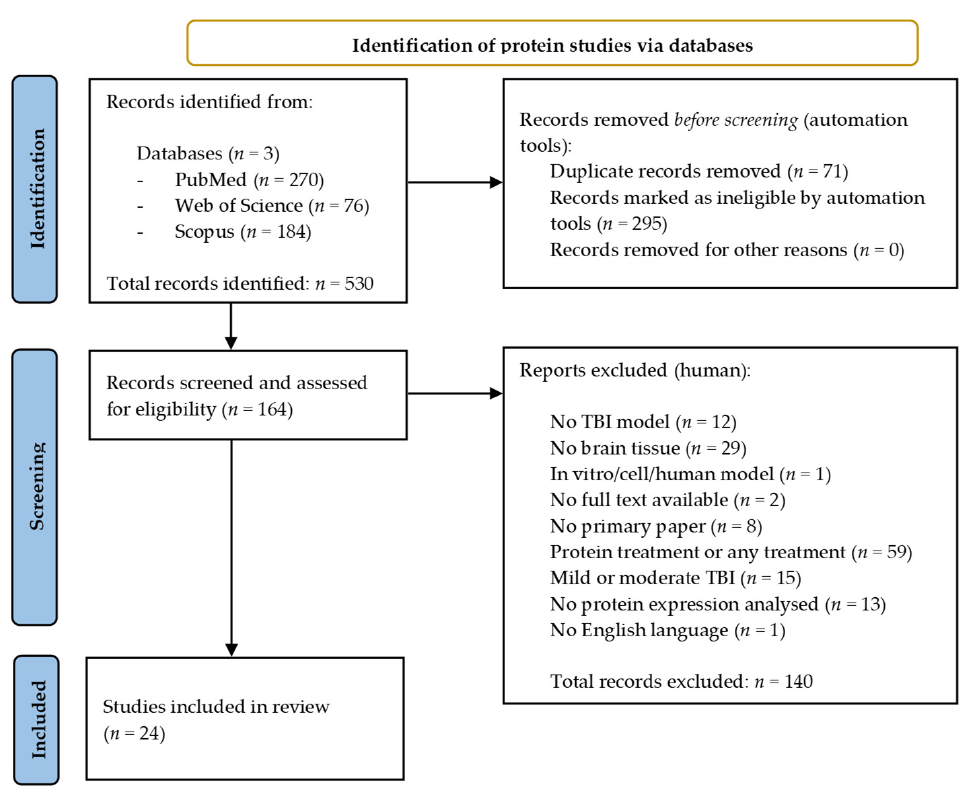
Figure 2. Preferred reporting items for systematic reviews and meta-analysis (PRISMA) flow chart detailing the literature search process for protein studies.